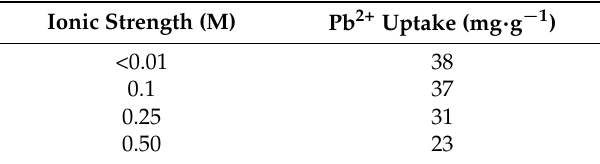
Table 8. Influence of the ionic of the strength aqueous solution on Pb 2+ adsorption onto the